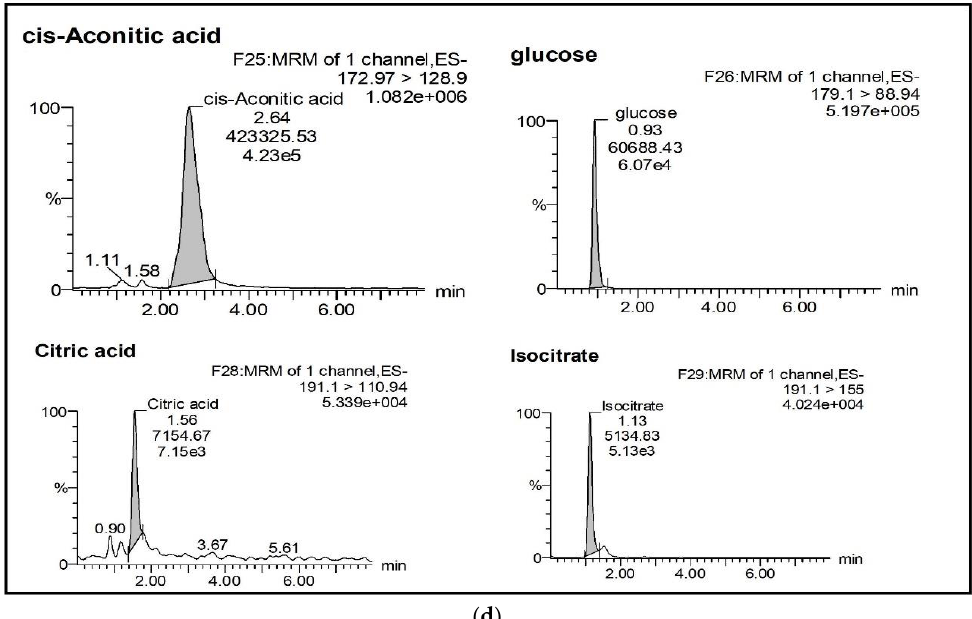
Figure 2. ( a ) Chromatogram of TCA cycle intermediate; ( b ) Chromatogram of TCA cycle intermediate; ( c ) Chromatogram of TCA cycle intermediate; and, ( d ) Chromatogram of TCA cycle intermediate.